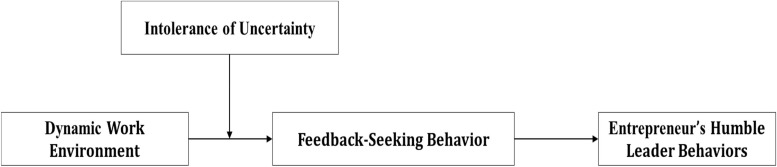
Research framework.